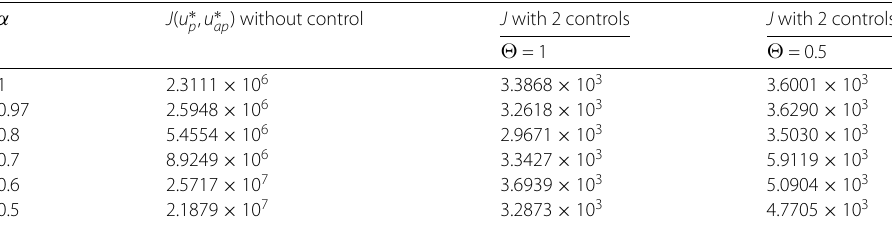
Table 3 GL-NWAFDM results of cost functional without and with controls, T f = 120 and φ ( (cid:2) t ) = (1 – e – (cid:2) t ) and different (cid:21) , α